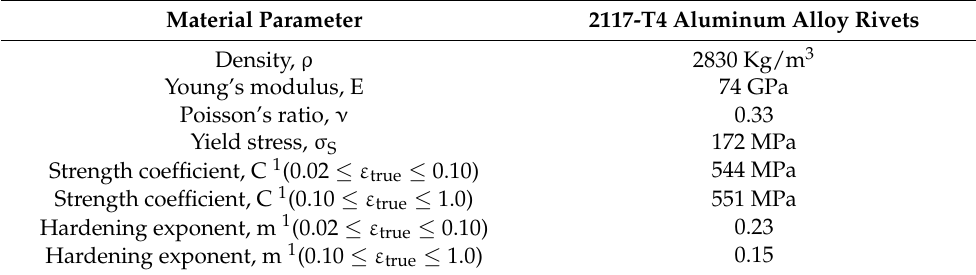
Table 1. Material parameters of 2117-T4 aluminum alloy rivets.